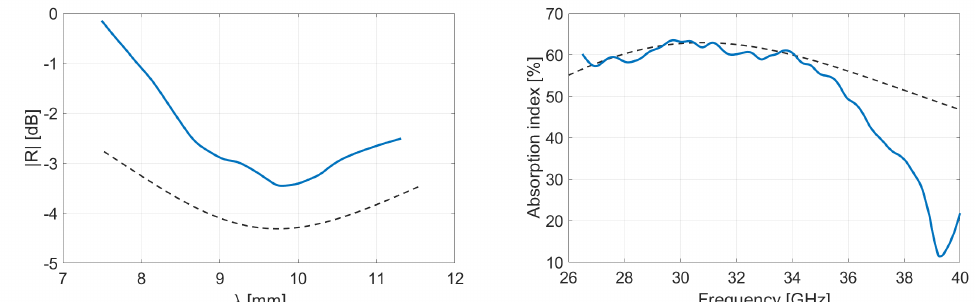
Figure 13. Reflectivity and absorption performances of the recycled Salisbury structure. The resistive layer is rPLA–4%OMMT 200 µm-thick film and the lossy material is rPLA 1.2 mm-thick. The dotted line is the simulation of the performance based on material properties.